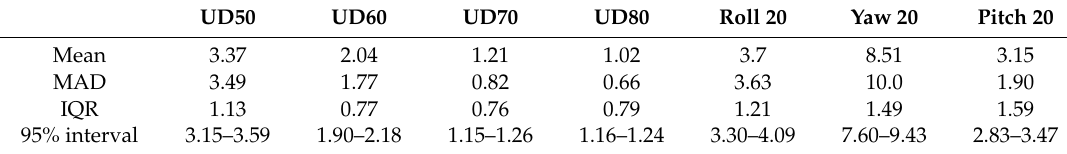
Table 6. Gaze error statistics from desktop experiments (table values in degrees).